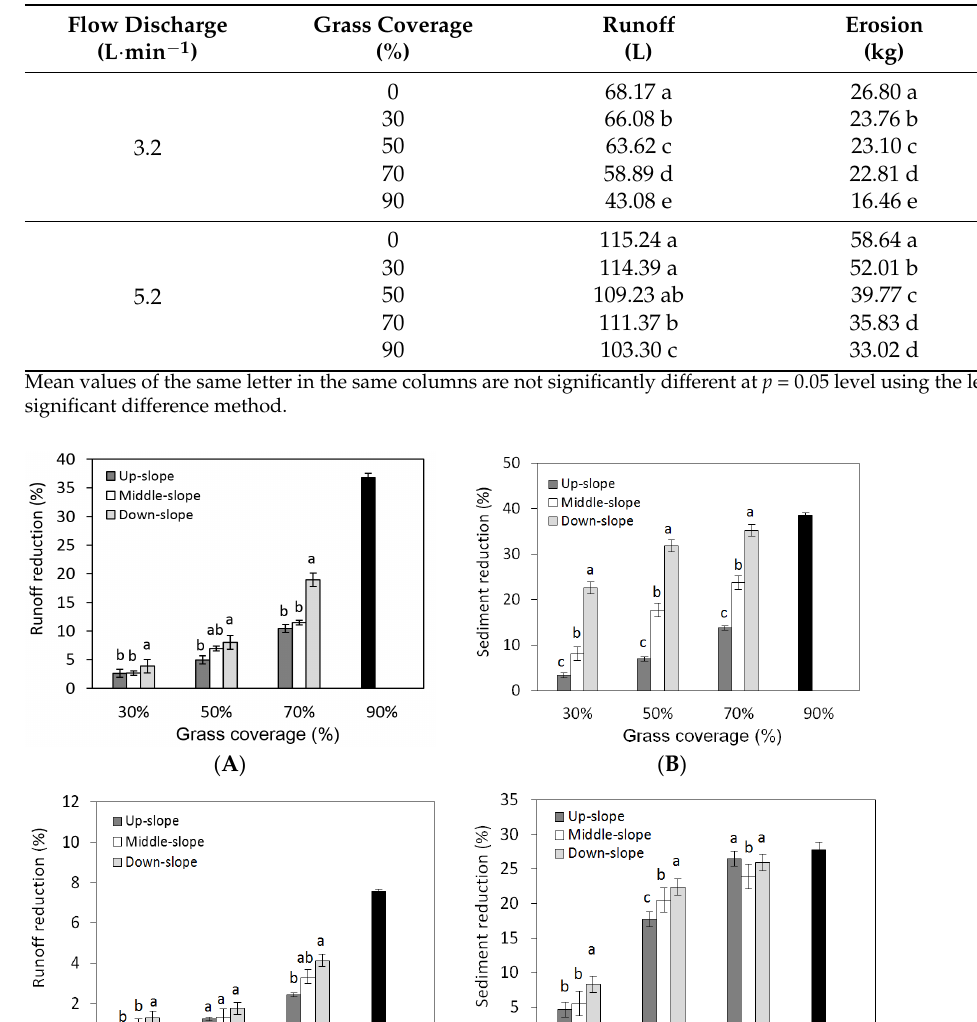
and flow discharges.